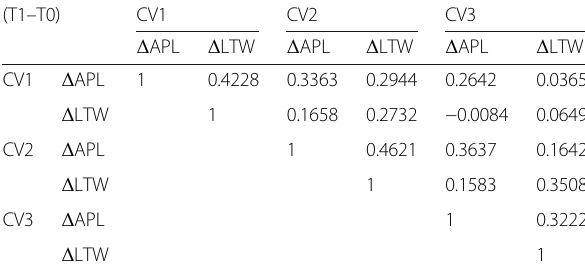
Table 7 Pearson correlation coefficient indicating the correlation between each